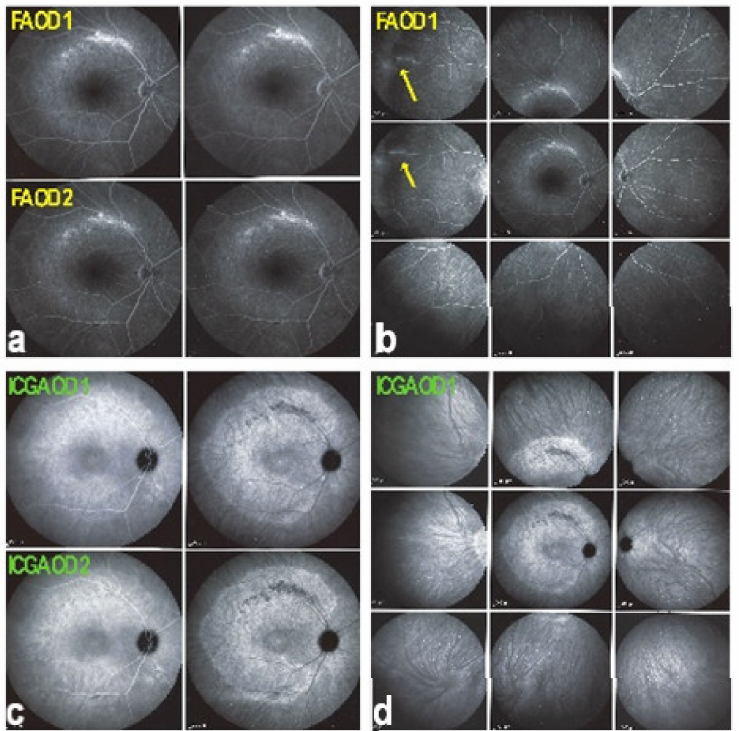
Figure 37. AZOOR. FA faint hyperfluorescence corresponding to the C-shaped hyperautofluorescent area on FAF OD (( a ), FA OD 1), including a zone inside this area of brighter hyperfluorescence (window defect), indicating chorioretinal atrophy. (a, FA OD 1). In the periphery on the right panorama supero-temporal vasculitis (( b ), FA OD 1, (arrows)). Late ICGA frames show hyperfluores- cence corresponding to the C-shaped hyperautofluorescent areas on FAF, indicating preservation of choriocapillaris, except in the area along the superior temporal arcade, which was hypofluorescent corresponding to hypoautofluorescence on FAF and hyperfluorescence on FA, all images indicating chorioretinal atrophy (ICGA OD 1, ( c ), and ICGA OD 1, ( d )). Images remained stable after infliximab therapy (a FA OD 2 and c, ICGA OD 2).